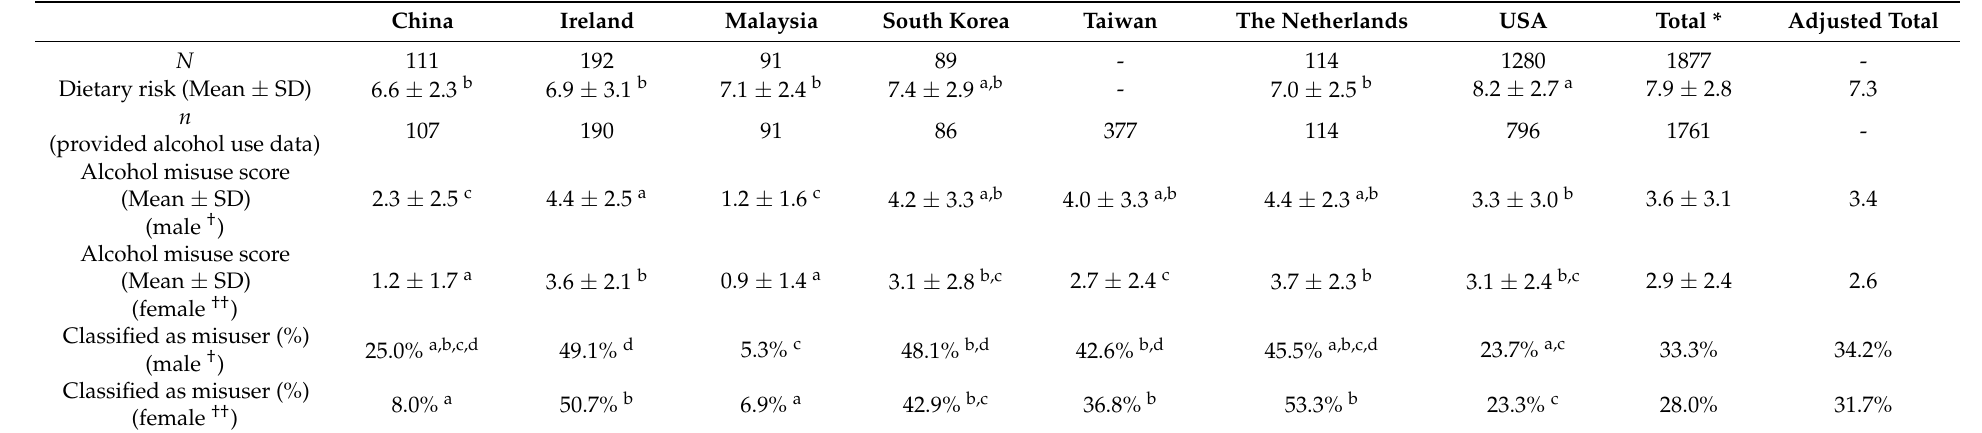
Table 3. Country comparisons of dietary risk and alcohol consumption.